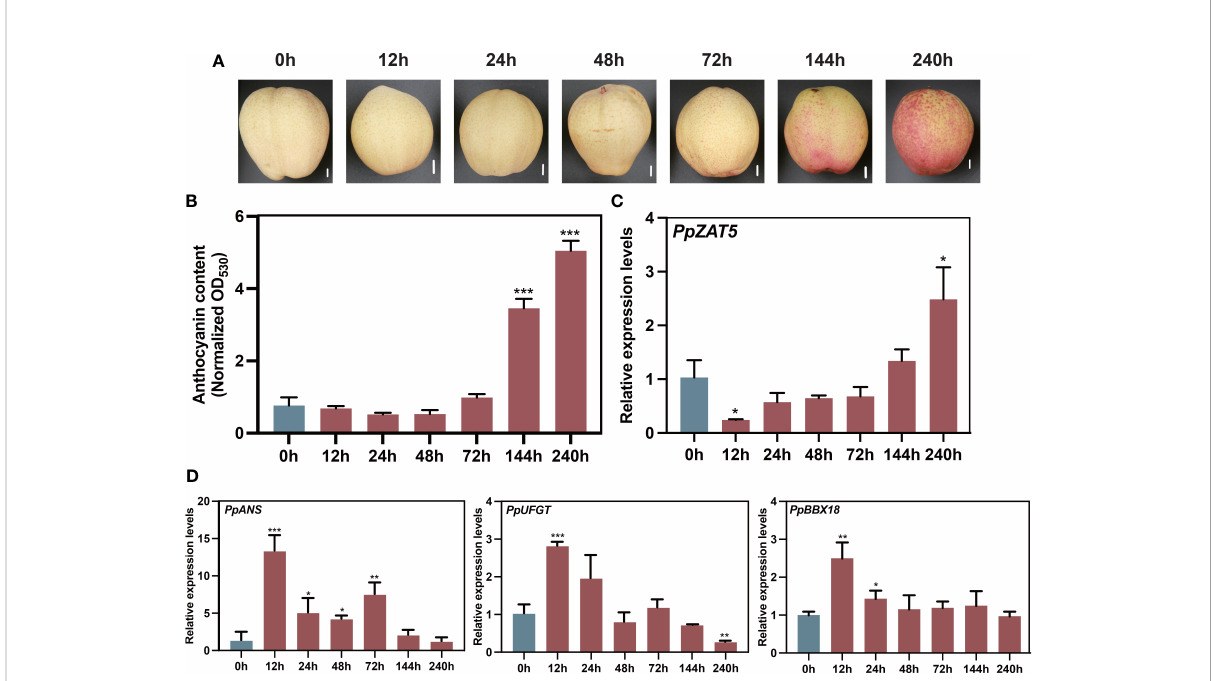
FIGURE 2 Light-responsive PpZAT5 expression. (A) Anthocyanin accumulation in the pear, ‘ Hongzaosu ’ fruit peel after the light treatment. Scale bars = 1 cm. (B) Changes in the fruit peel anthocyanin contents during the light treatment. (C) PpZAT5 expression pattern during light treatment. (D) PpANS , PpUFGT expression patterns during light treatment. Error bars for anthocyanin contents and expression levels represent the standard deviation of three independent experiments. Asterisks indicate signi fi cant differences (two-tailed Student ’ s t -test, *P < 0.05, **P < 0.01, ***P <